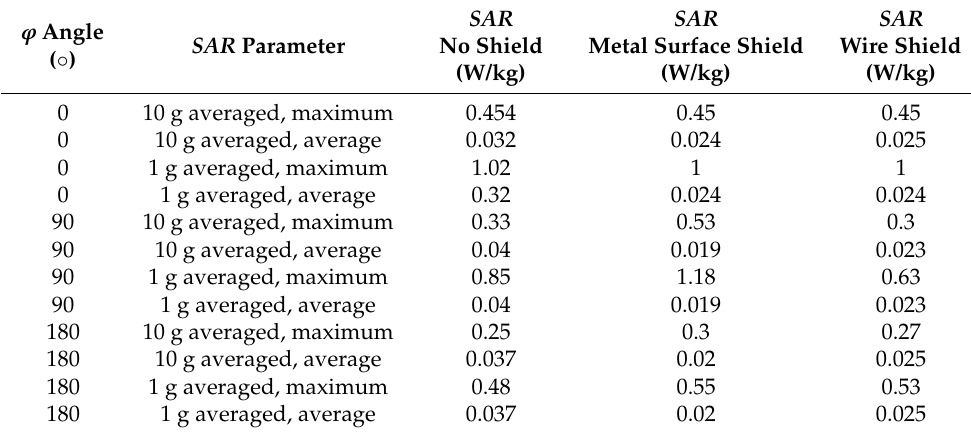
Table 3. SAR parameters for 3600 MHz, for θ = 90 ◦